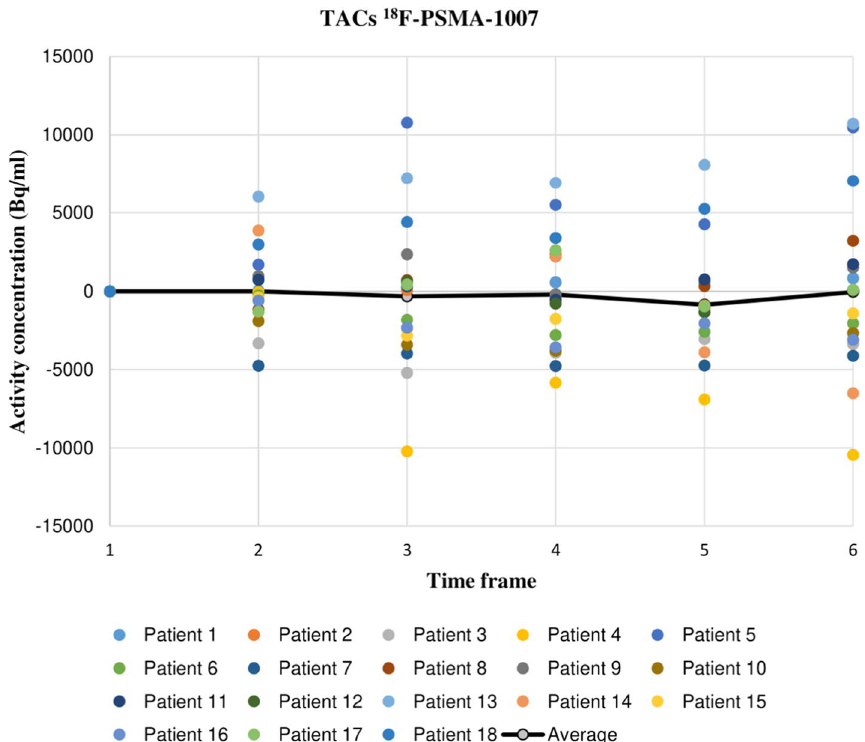
Fig. 3 18 F-PSMA-1007 time-activity curves, normalized from the baseline “zero” time